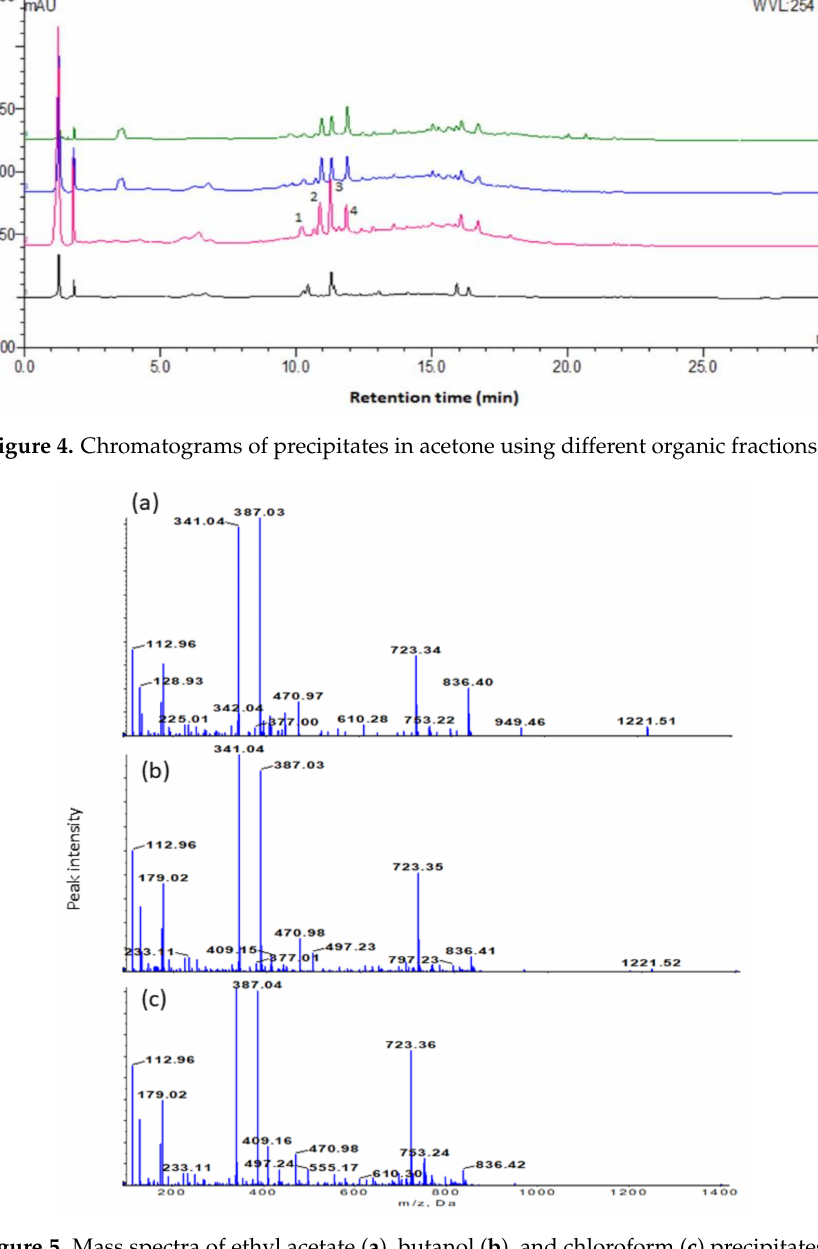
Figure 5. Mass spectra of ethyl acetate ( a ), butanol ( b ), and chloroform ( c )